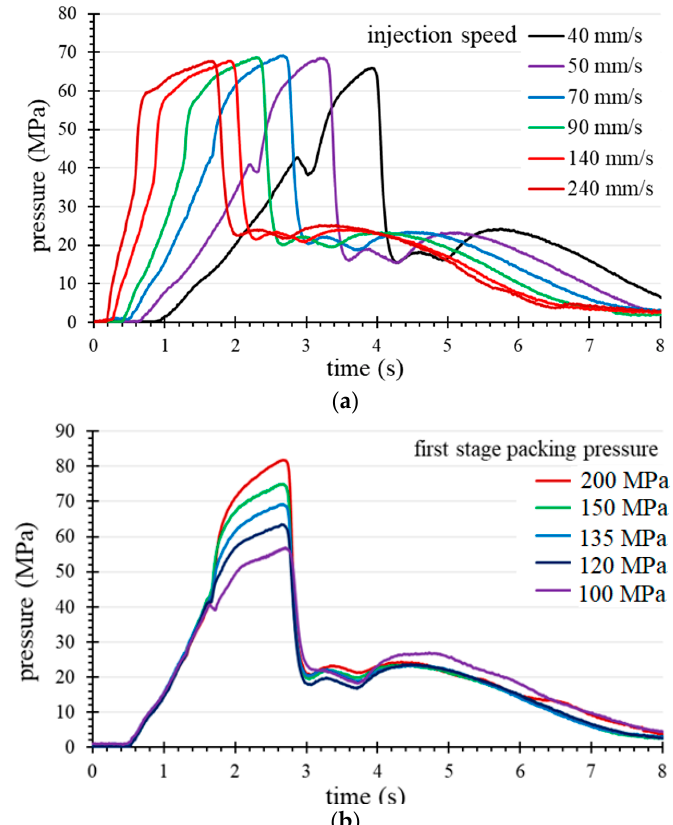
Figure 12 . The P1 pressure variation with ( a ) injection speed (first stage packing pressure 135 MPa) and ( b ) first stage packing pressure (injection speed 70 mm/s).